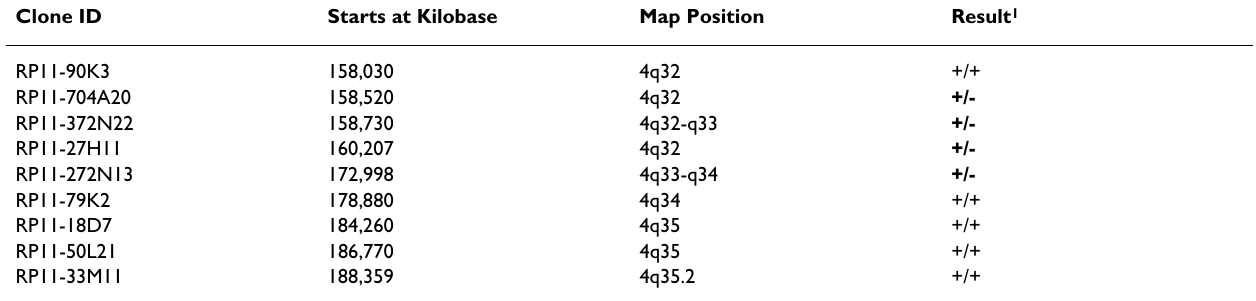
Table 2: AU0052-0201 FISH data summary Clone ID